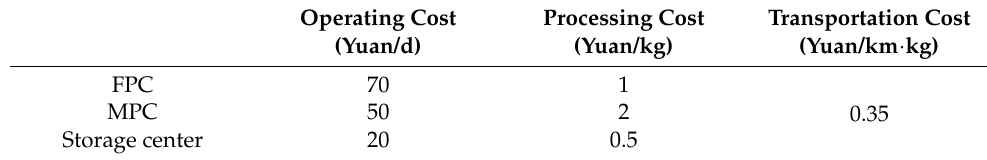
Table 2. Cost related parameters.